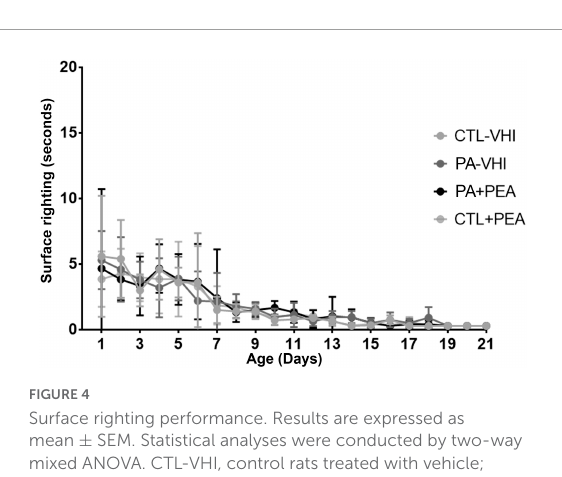
Negative geotaxis appeared later in PA-VHI than in CTL-VHI rats, but concurrently in PA-PEA and PA-VHI ( p = 0.81), and CTL-PEA and CTL-VHI rats ( p = 0.39).